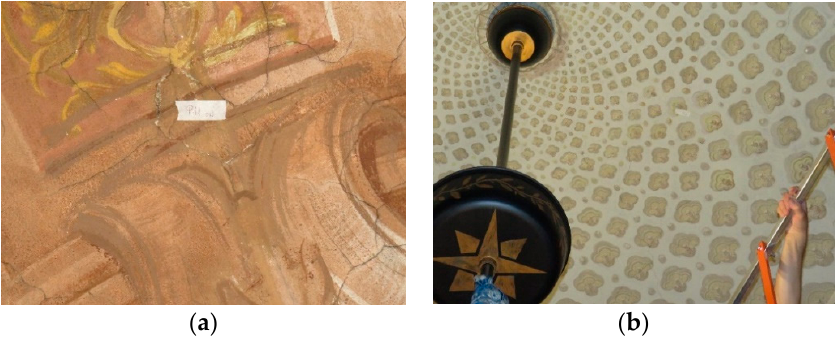
Figure 14. Points of potential plaster detachment: ( a ) P11 vault Pelagi room; ( b ) P15 vault Giunta